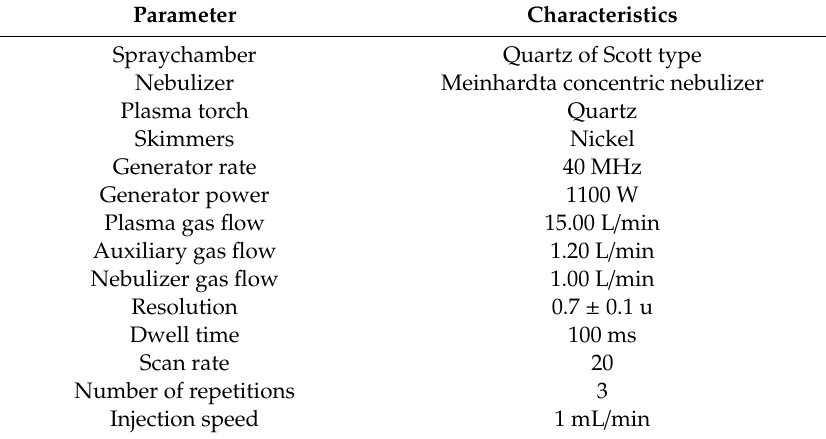
Table 1. Parameters in the determination of selenium with the use of